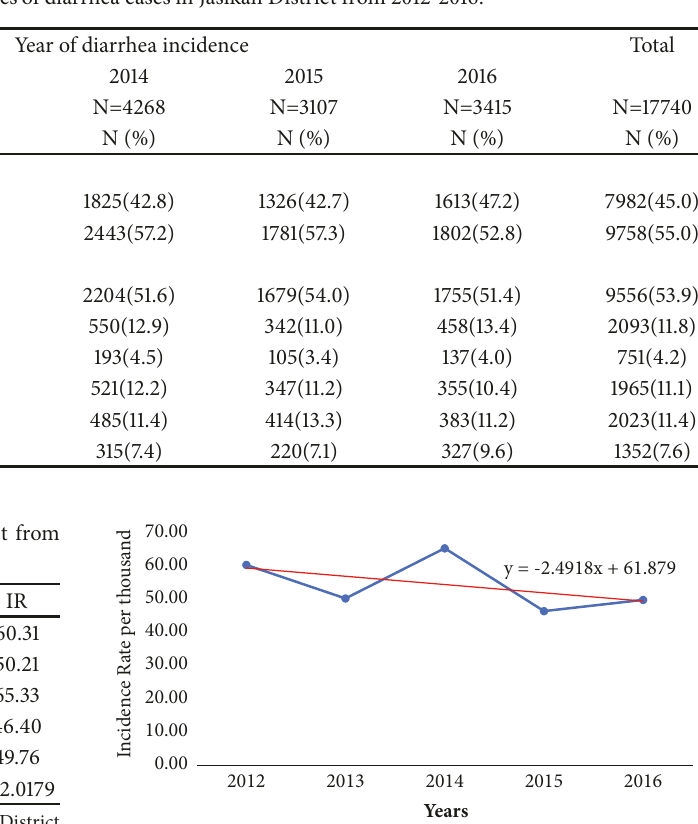
Figure 1: Incidence rate of diarrhea cases in Jasikan District from 2012 to 2016.